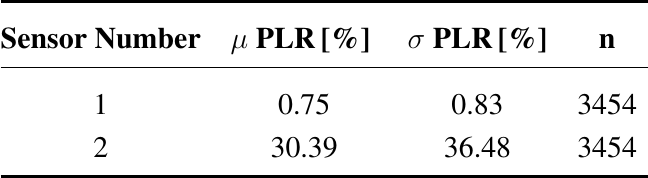
Table 5. Data from measurement of PLR measurement with two IPANEMA generation 2 nodes. n = the total number of generated